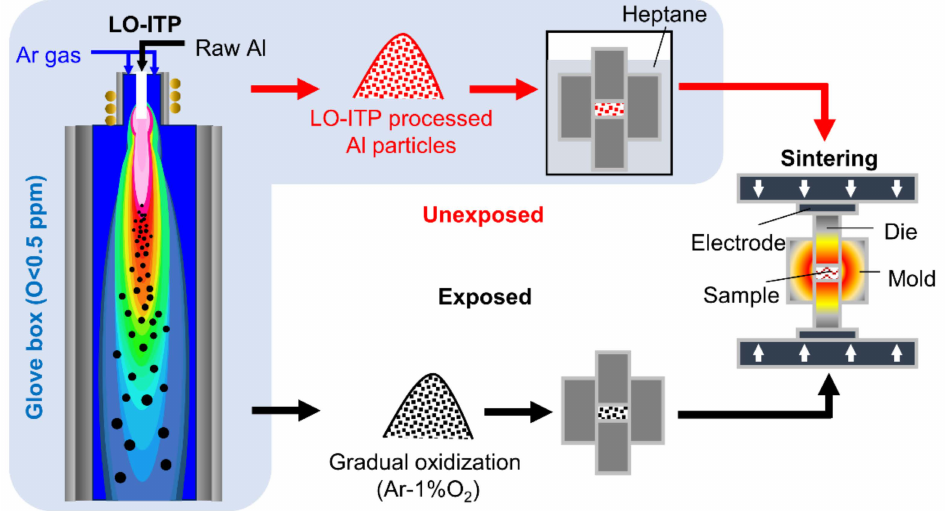
Figure 1. Schematic illustration of the experimental procedures. There were two routes. “Unexposed” indicates that the powder was not exposed to oxygen. “Exposed” indicates that the powder was gradually oxidized in a 1% O 2